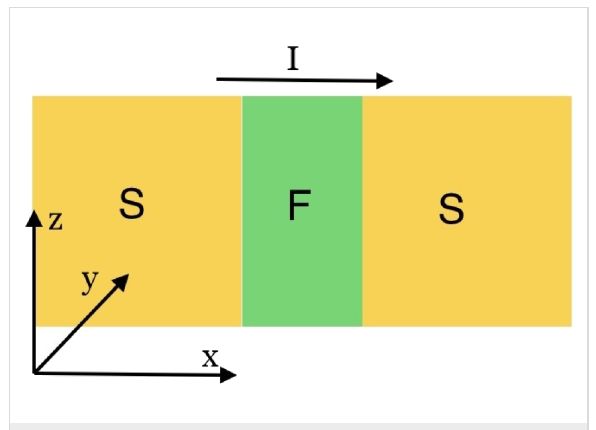
Figure 1: Schematic view of a SFS φ 0 Josephson junction. The external current is applied along the x direction. The ferromagnetic easy axis is along z